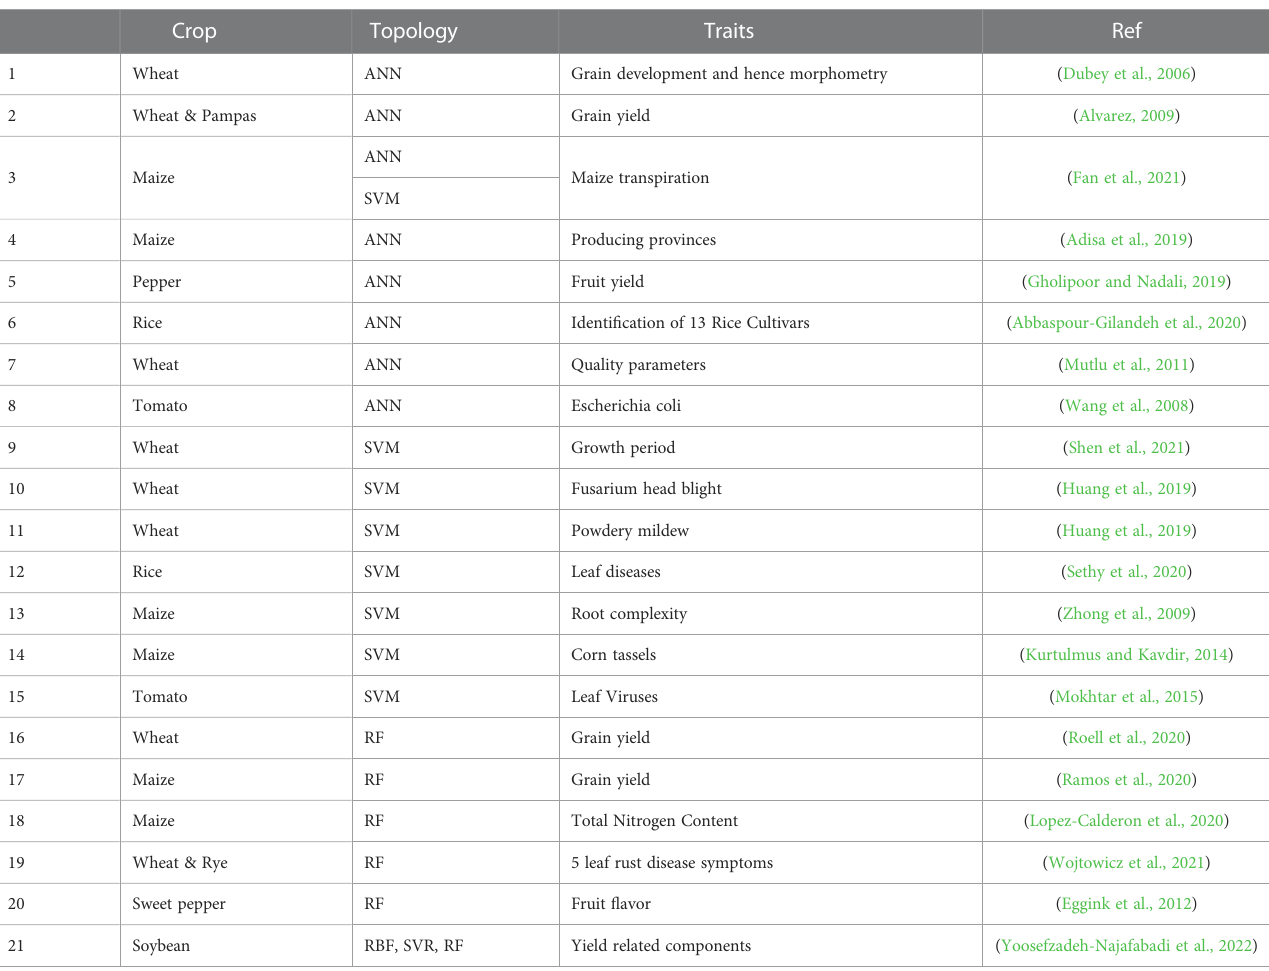
TABLE 2 Machine learning application to GS in